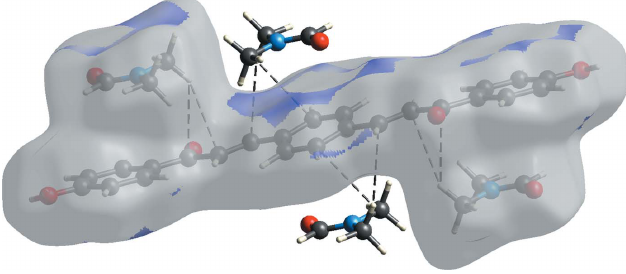
Figure 7 d norm mapped on Hirshfeld surfaces to visualize the weak intermolecular C—H (cid:2)(cid:2)(cid:2) (cid:5) and C—H (cid:2)(cid:2)(cid:2) alkene interactions in the title compound.